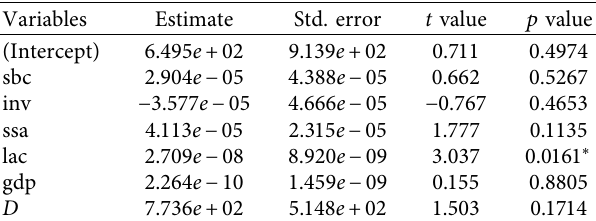
Table 2: Analysis of regression equation